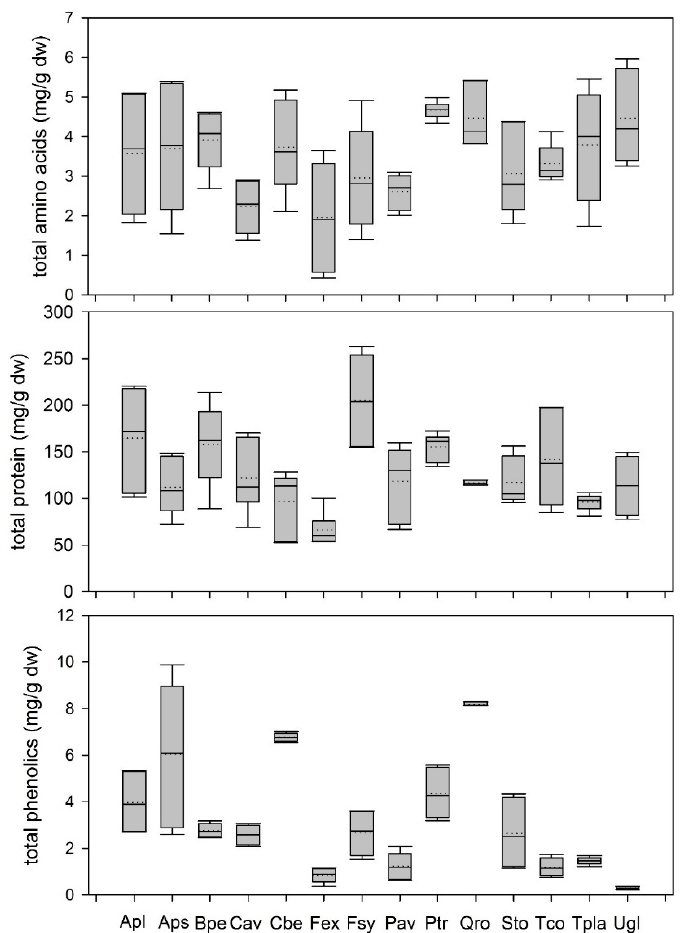
Figure 4. Total soluble amino acid ( top ), protein ( center ), and phenolic (bottom) concentration (mg/g dw) in green leaves. Boxplots show mean (dotted line) and median (straight line) for the combined years. Data for Q. robur is only available for the first year. Apl = Acer platanoides , Aps = Acer pseudoplatanus , Bpe = Betula pendula , Cav = Corylus avellana , Cbe = Carpinus betulus , Fex = Fraxinus excelsior , Fsy = Fagus sylvatica , Pav = Prunus avium , Ptr = Populus tremula , Qro = Quercus robur , Sto = Sorbus torminalis , Tco = Tilia cordata , Tpla = Tilia platyphyllos , Ugl = Ulmus glabra .